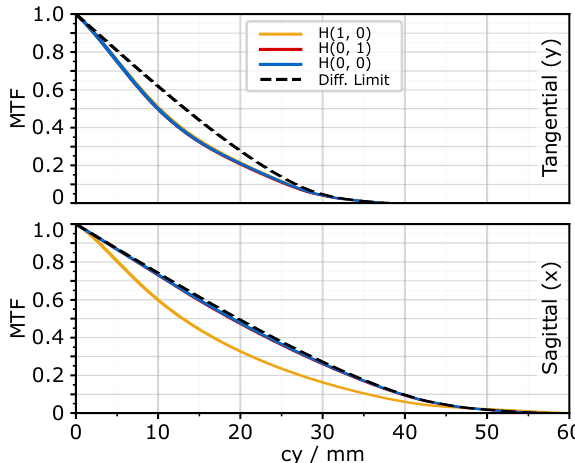
Figure 2. Simulated image-side MTF of the system with on- axis field and maximal field each in x and y. Fields are given in normalized field coordinates H ( x ,y ).